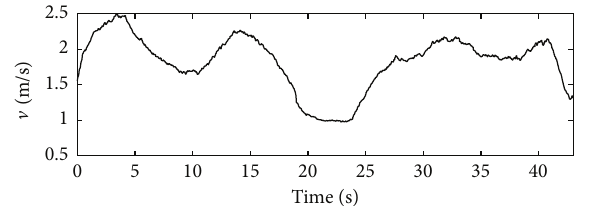
Figure 18: Velocity of obstacle avoidance at low speeds.